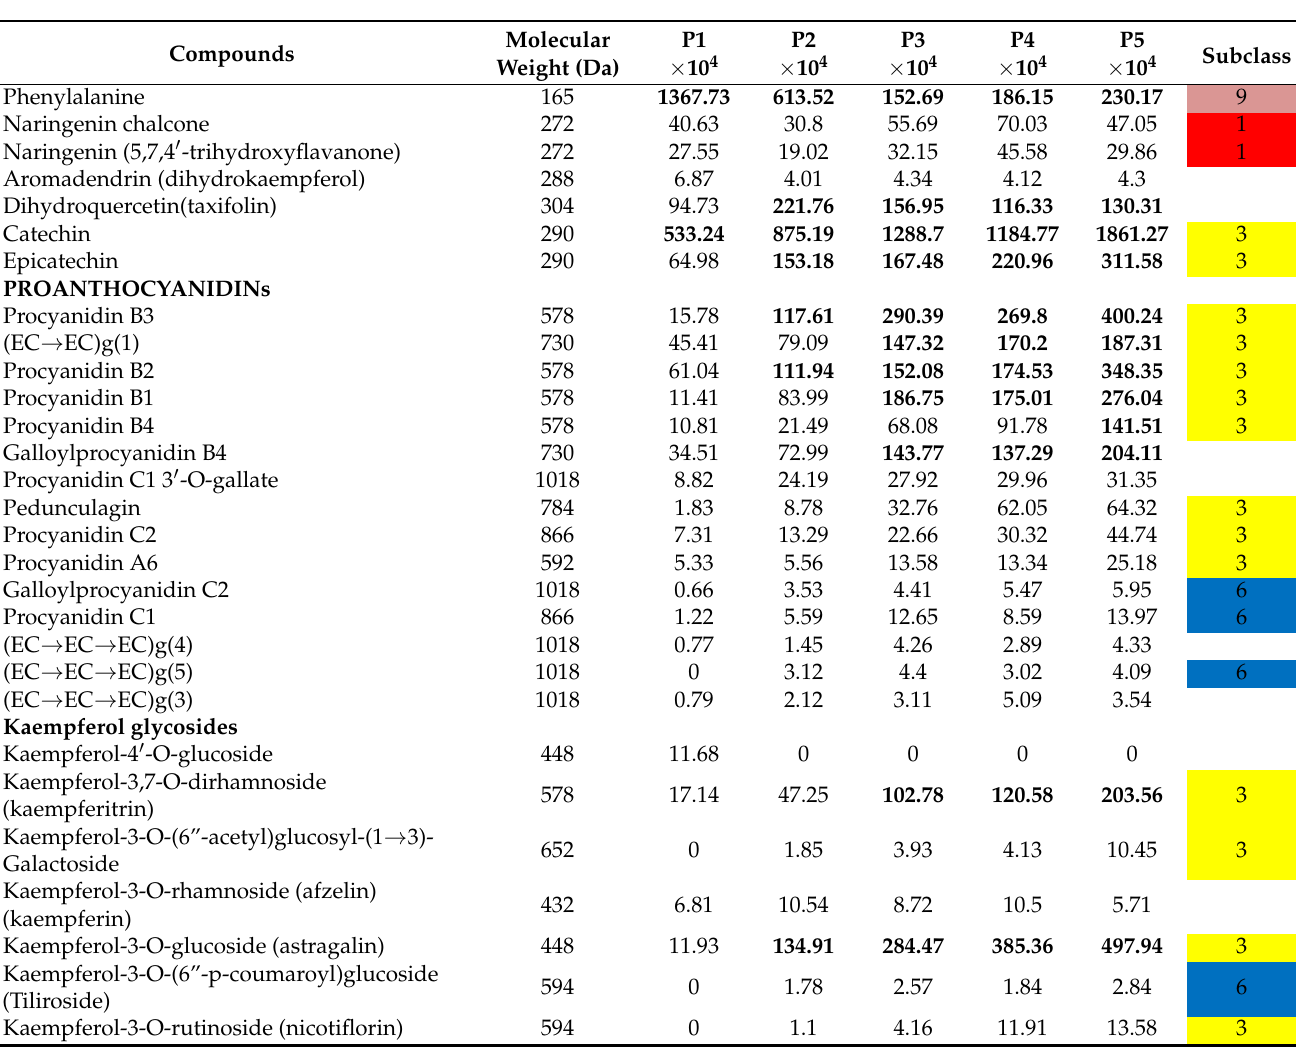
Table 2. Identification of polyphenol-related metabolites in the developing walnut endopleura. The compounds with values > 100 × 10 4 are highlighted with bold font. The nine color subclasses are from Figure